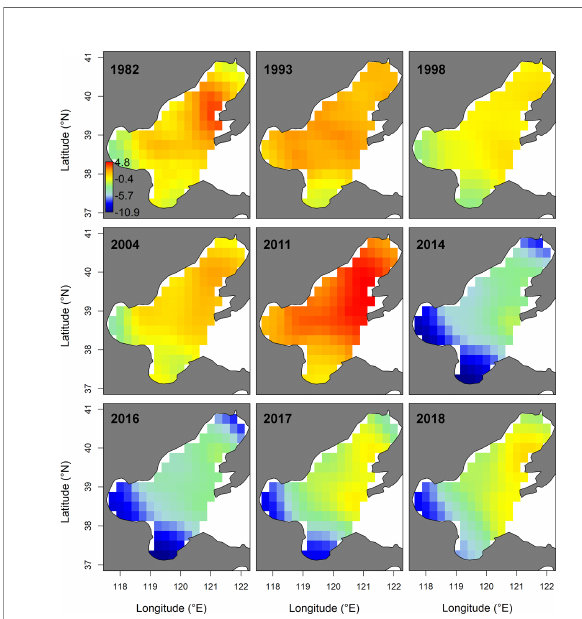
FIGURE 3 | Spatio-temporal distribution of log-density for the small yellow croaker stock of the Bohai Sea in spring of 1982 − 2018, predicted by the Akaike ’ s information criterion (AIC)-selected model developed for the stock. The color legend with units ln(kg.km -2 ) is provided in the fi rst panel and has. Only projections for years where sampling for the stock were available (i.e., 1982, 1993, 1998, 2004. 2011, 2014 and 2016 – 2018) are presented.